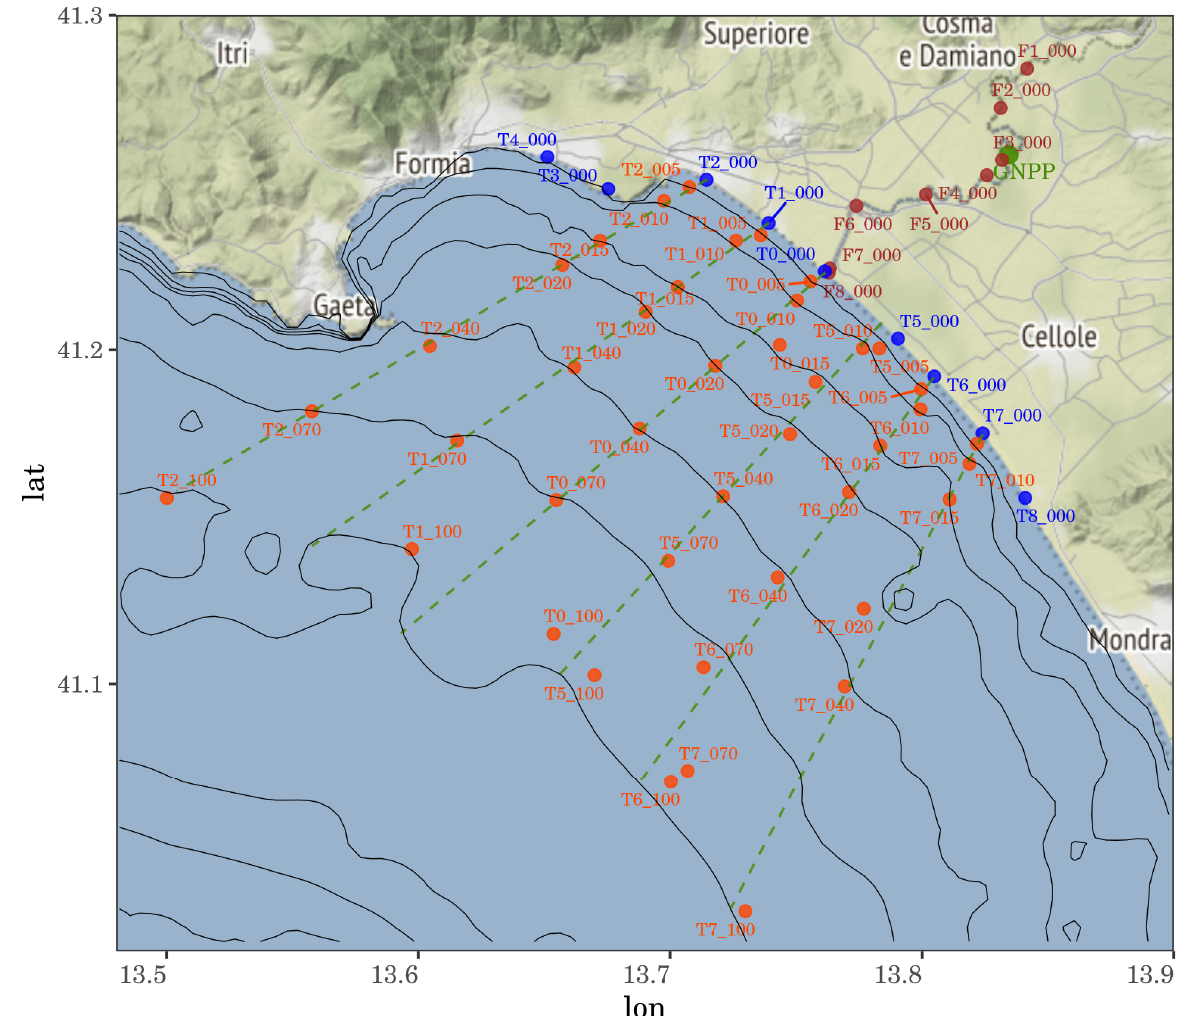
Figure 1. Map with the location of the sampling points. In blue are the sediment and coastal water sampling points; in orange: the points for deep and superficial marine waters and marine sediments; in dark red: the points of fluvial waters and sediments. The GNPP is indicated in green; its distance from the sea is 7 km. The bathymetric lines at 5, 10, 15, 20, 40, 70, and 100 m are also shown.